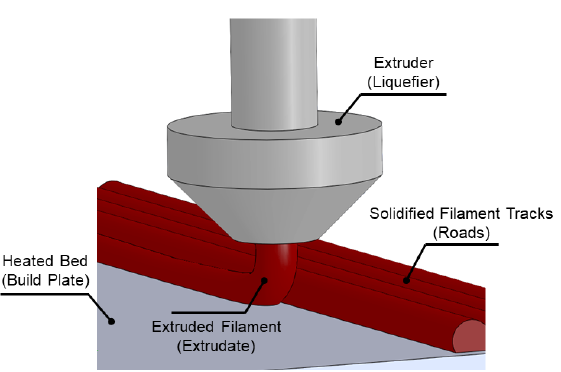
Figure 2. Schematic of fused filament fabrication